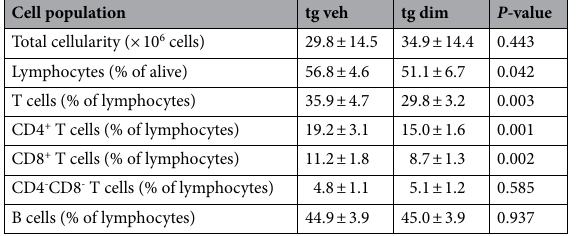
Table 2. Total spleen cellularity and frequencies of cell populations within the spleen. Data are arithmetic mean ± standard deviation. tg, transgene; veh, vehicle; dim, dimerizer n = 10 veh and 10 dim mice. Student’s